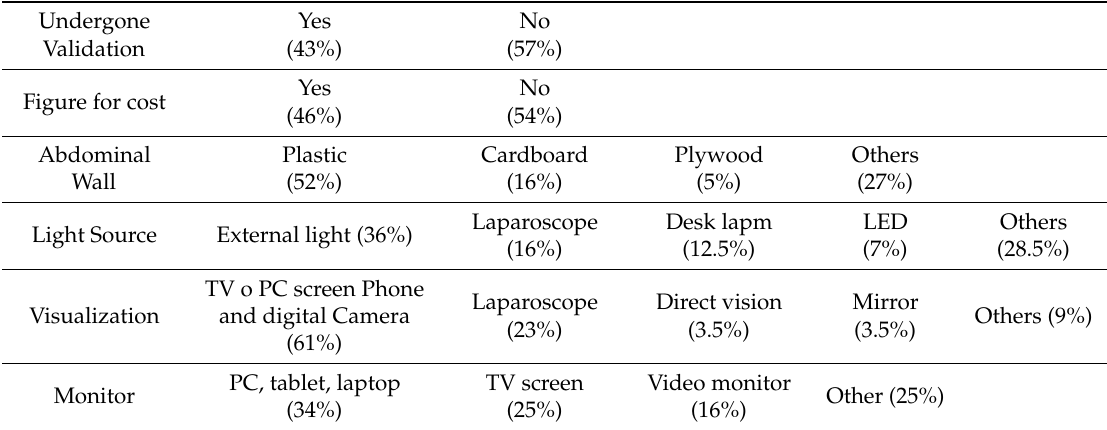
Table 1. Analysis of the characteristics of some of simulator boxes published in the recent